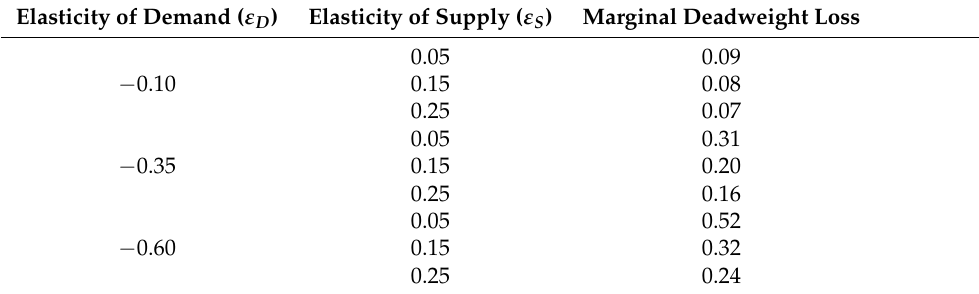
Table 6. Sensitivity of Marginal Deadweight Loss to Elasticity Assumptions.